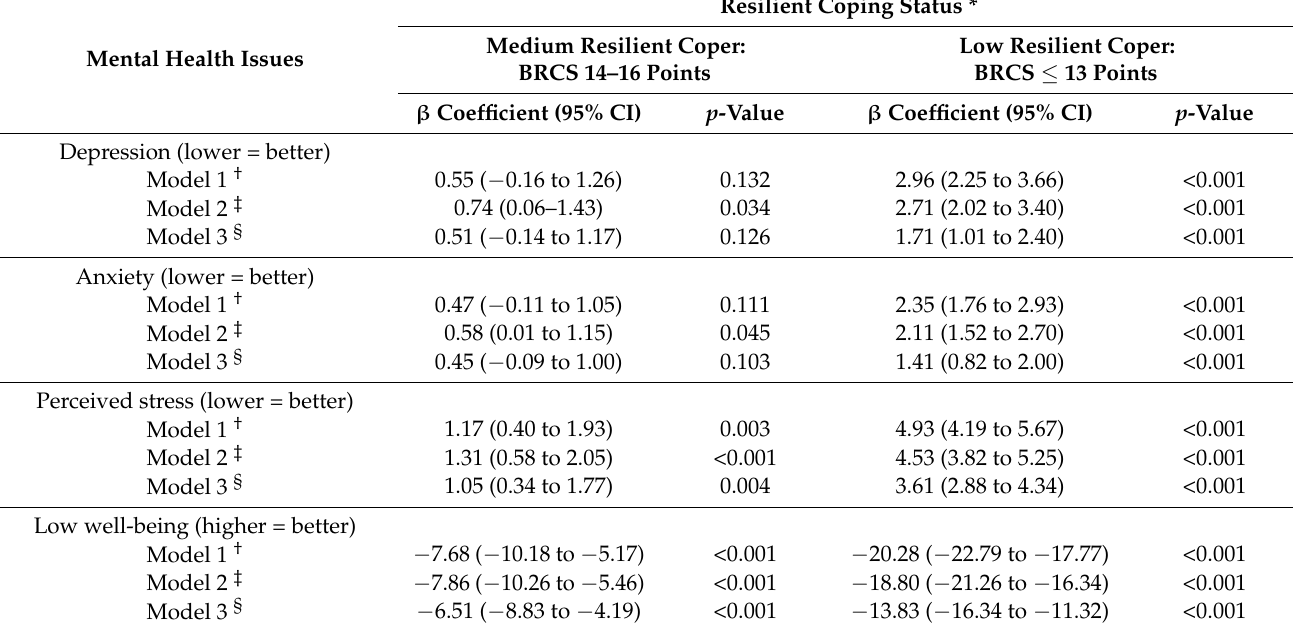
Table 5. Ancillary analysis: Multivariable linear regression model results of resilient coping status and the risk of mental health